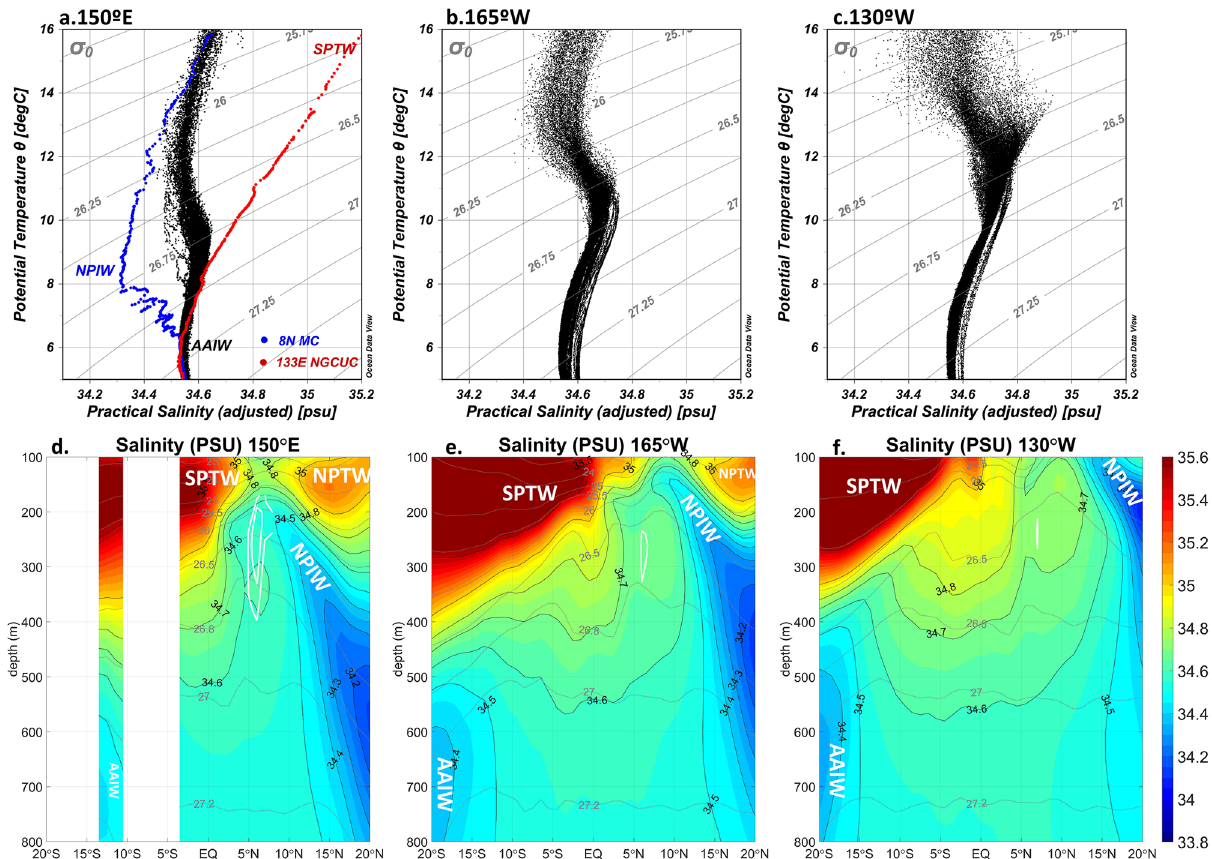
Figure 4. T–S relations of sea waters based on Argo profiles between 4° N and 6° N within 5° of longitude from 150° E in the western basin ( a ), and between 6° N and 8° N within 5° from 165° W and from 130° W in the central ( b ) and the eastern ( c ) basins. CTD station profiles at 8° N, 127° E and 0.45° S, 133.5° E representing the intermediate waters of the MC and NGCUC are overlapped in ( a ) to represent the typical water masses from the North and South Pacific. Salinity distributions (thin black contours with color shading) in meridional sections of 150° E ( d ), 165° W ( e ), and 130° W ( f ). In ( d – f ), the NESC cores are marked by the westward mean geostrophic velocity contours (white) at the interval of 1.0 cm s −1 and the density surfaces are plotted as thick grey contours. Units of the potential temperature, salinity, and potential density are degree Celsius, psu, and kg m −3 , respectively. Salinity maxima of the North Pacific Tropical Water (NPTW) and South Pacific Tropical Water (SPTW), and salinity minima of the North Pacific Intermediate Water (NPIW) and the Antarctic Intermediate Water (AAIW) are marked in the panels ( d – f ). ( a – c ) is generented by Ocean Data View software version 5.1.0 (https ://odv.awi.de/). ( d – f ) is generented by MATLAB software version R2019b (https ://www. mathw NESC is distinct from the intermediate current systems down below at the 1,000 m Argo parking depth and at the deeper intermediate depths. Water masses. The water masses of the NESC appear to be the mixture of the North and South Pacific waters according to the T–S relation of Argo profiles (Fig. 4a–c). In the equatorial Pacific Ocean, high salinity waters are transported across the equator by the NGCC/UC in the western Pacific and are carried to the east by the NSCC in the sub-thermocline, forming a salinity front between northern and southern Pacific water masses 11,12 . The water masses immediately north of the equator have a salinity maximum (> 35 psu) in the ther- mocline, which is called the South Pacific Tropical Water (SPTW) generated in the subtropical gyre of the South Pacific, and a salinity minimum (between 34.5 psu and 34.6 psu) at the intermediate depths, which is called the Antarctic Intermediate Water (AAIW) generated in the Southern Oceans 13 . In the North Pacific, the water mass with a salinity maximum (> 34.75 psu) is called the North Pacific Tropical Water (NPTW), which is generated in the subtropical gyre of the North Pacific 13 . In the intermediate depths in the North Pacific, the water mass with a salinity minimum (< 34.4 psu) is called the North Pacific Intermediate Water (NPIW), which is generated in the subpolar North Pacific 13,14 . The NESC is located between density layers of σ θ = 26.0 kg m −3 and σ θ = 27.0 kg m −3 (Fig. 4d–f). The salin- ity distributions in the meridional sections across the equatorial Pacific suggest that the NESC is located at the southern edge of the NPIW, with the South Pacific waters of higher salinity immediately to its south. The fact